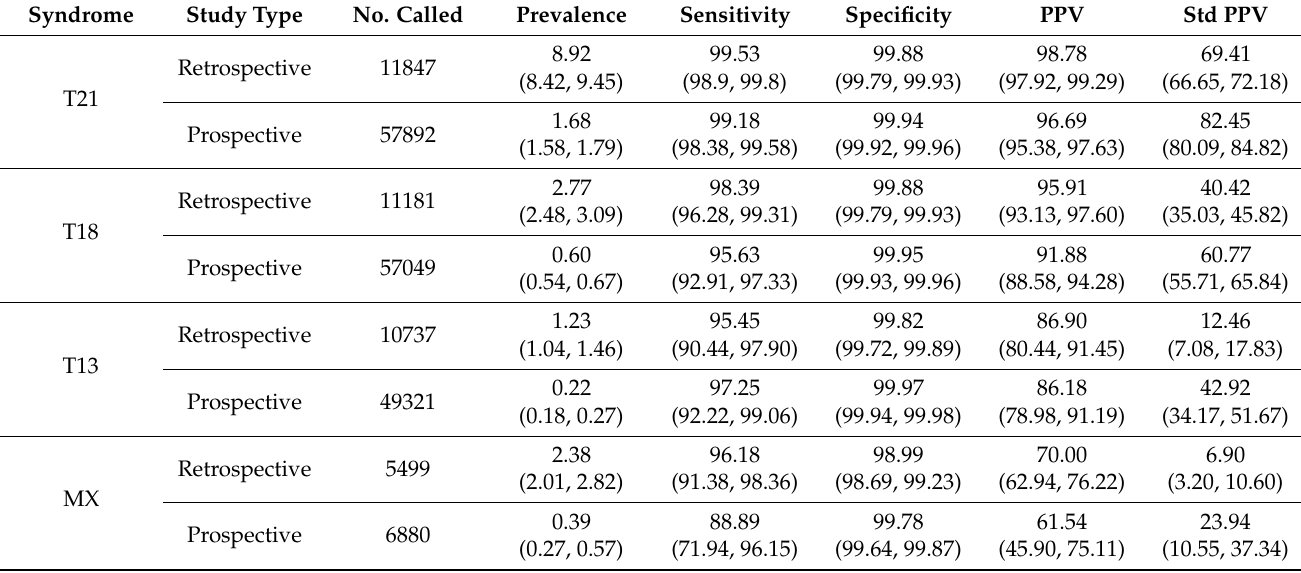
Table 4. Validation studies: pooled estimates by syndrome and study type.